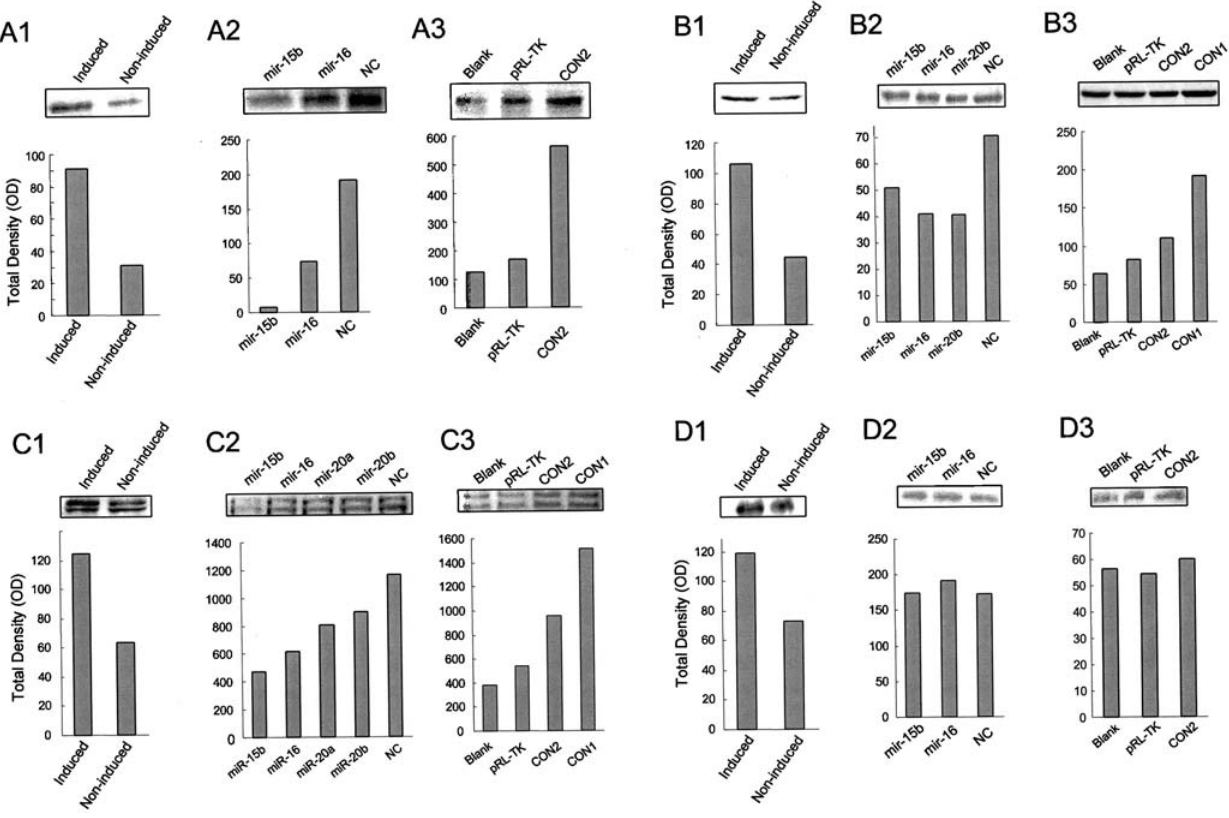
Figure 6. Co-regulation of miRNAs to angiogenic factors. CNE cells were induced with or without DFOM (6–1), transfected with miR-15b, miR-16, miR-20a , or miR-20b (6–2) and transfected with Construct I or Construct II (6–3). Cell lysate was collected, and the expression of angiogenic factors uPAR (A), COX2 (B), c-MET (C), and PTN (D) were determined by Western Blotting.